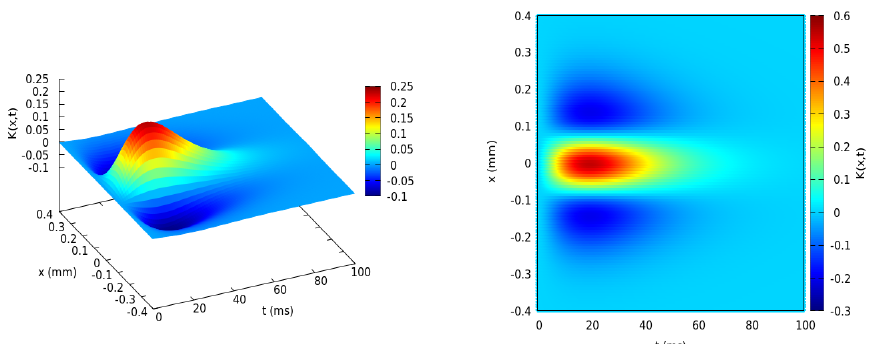
Figure 2. Receptive Field of a ON BCell. ( Left ) Example of a spatio-temporal RF of B cells (ON center cell) represented in 3D (one dimension of space, x and time t ). There is inhibition at the surround, physiologically due to H cells. ( Right ) Spatio-temporal RF representation with a color